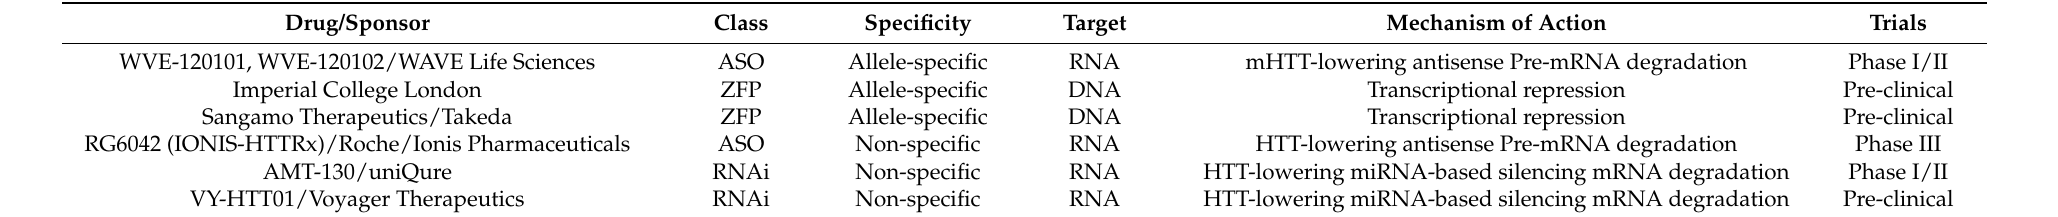
Table 1. Huntingtin lowering therapies targeting DNA and